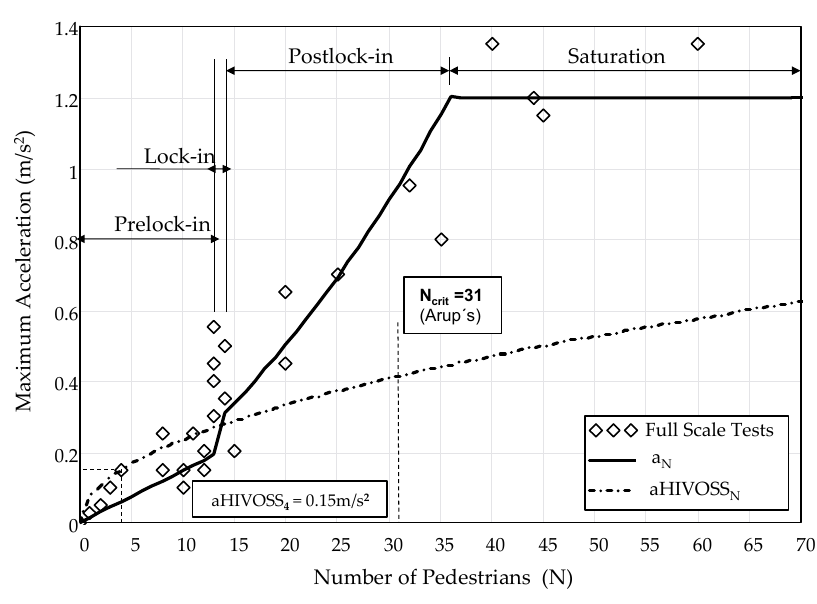
Figure 11. The Lardal footbridge. Analysis of the results.